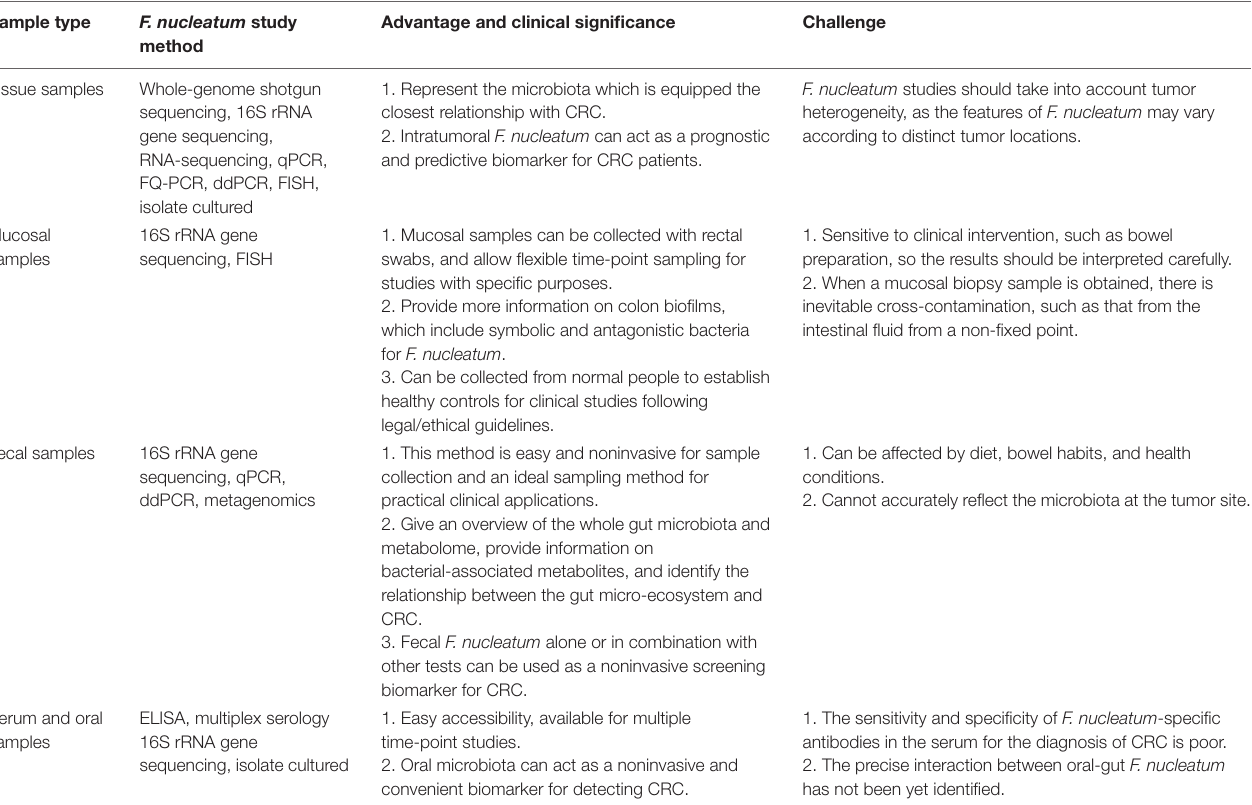
TABLE 1 | The advantages, clinical significance, and challenges of different sample types for F. nucleatum